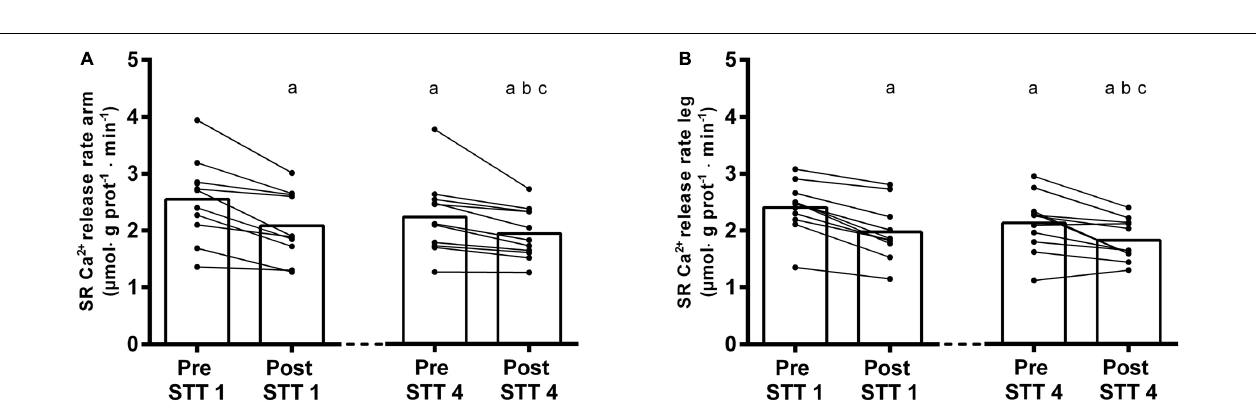
FIGURE 3 | SR Ca 2 + release rates in arms (A) and legs (B) of elite cross-country skiers before (Pre) and after (Post) the first (STT 1, n = 10) and the fourth (STT 4, n = 11) bout of 1300-m high-intensity skiing. Each bout was interspersed with 45 min of recovery including carbohydrate intake. Both individual changes and mean values are shown; a different from Pre STT1, b different from Post STT1, c different from Pre STT4. See text for exact p -values.